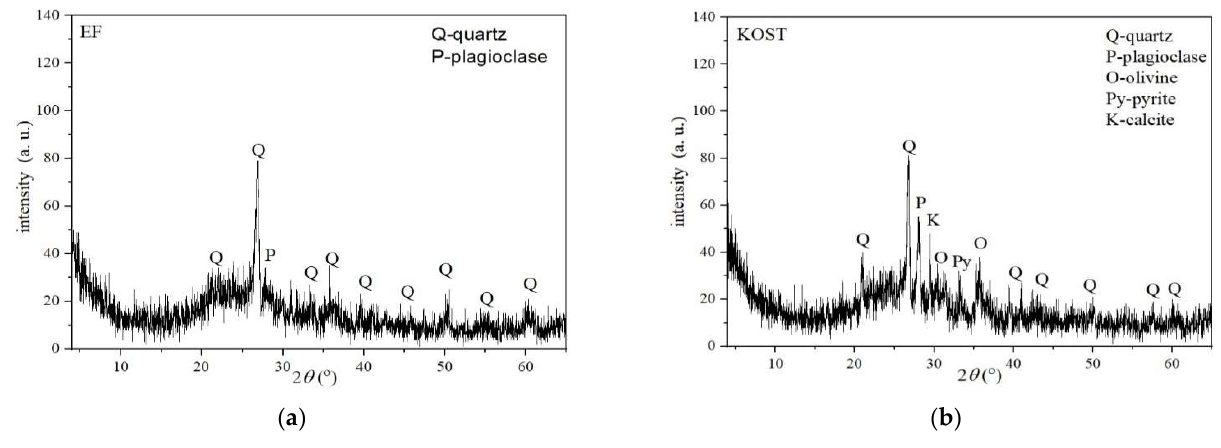
Figure 2. XRD diffractogram of fly ash samples: EF ( a ) and KOST ( b ). Table 2. Mineral and chemical analysis of fly ash samples EF and KOST Major Components % ± SD